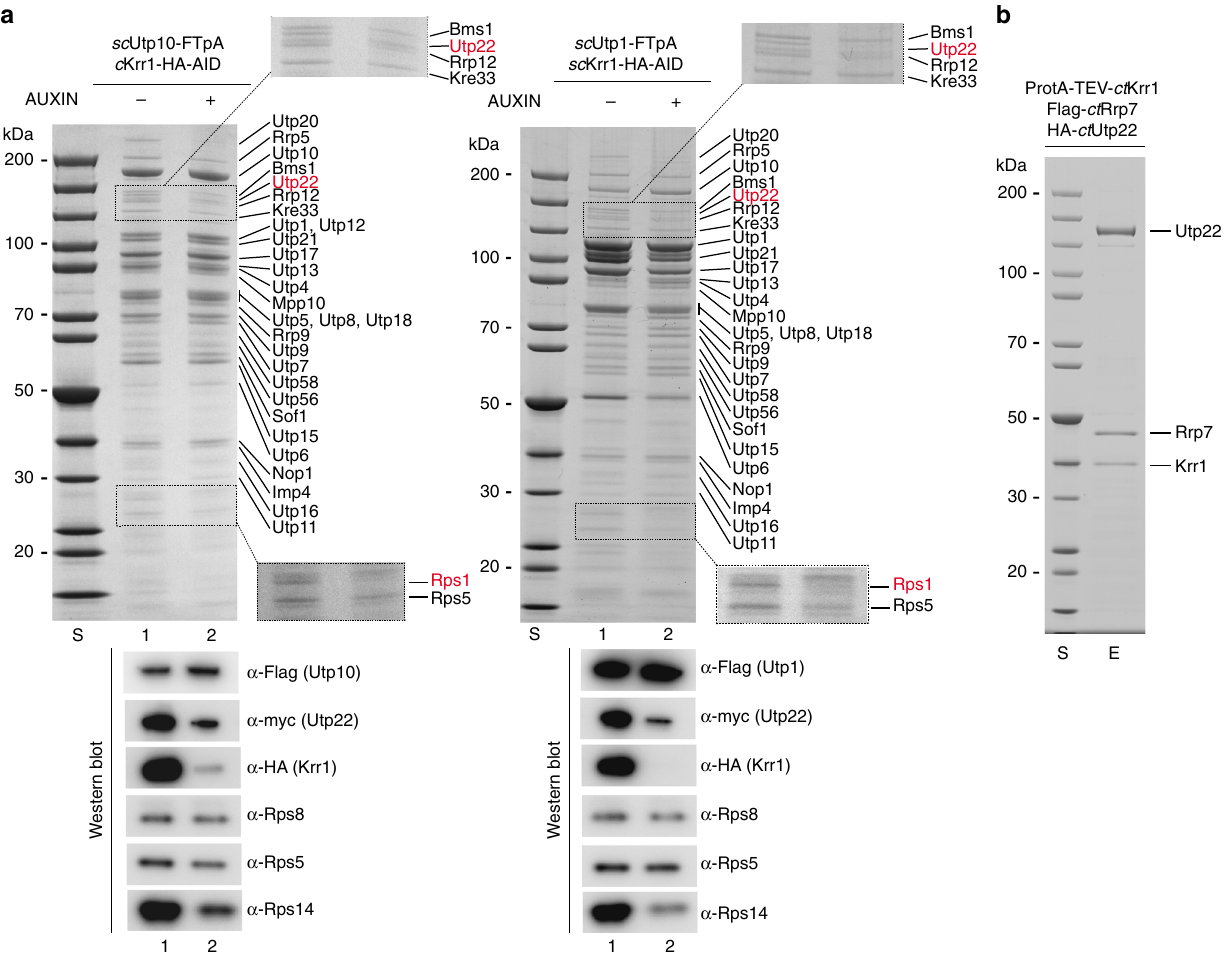
Fig. 5 Krr1 is required for recruitment of Rps1, Rps14 and UTP-C to the 90S pre-ribosome. a Depletion of Krr1 causes recruitment defects of the UTP-C complex, Rps14, and Rps1 to the 90S pre-ribosome. A yeast Krr1 degron strain ( sc Krr1-HA 3 -AID) expressing integrated sc Utp10-FTpA and sc Utp22-myc were grown in YPD medium, before degradation of Krr1 was induced by addition of indole-3-acetic acid (Auxin) to the medium and further growth for 90 min. Subsequently, sc Utp10-FTpA was af fi nity-puri fi ed and the eluates derived from the non-depleted and Krr1-depleted strains, respectively, were analyzed by SDS-PAGE (4 – 12%) and Coomassie staining (upper panel), or western blotting (lower panel) using the indicated antibodies. Dashed box is a zoom of the respective gel region to better display the Utp22/Rps1 depletion. Indicated proteins were identi fi ed via mass spectrometry. b Krr1 forms a complex with Utp22 and Rrp7 in vitro. The indicated ct Utp22-Rrp7-Krr1 complex was assembled by co-expression of the corresponding Chaetomium thermophilum factors in yeast followed by split-tag tandem af fi nity-puri fi cation. The fi nal eluate was analyzed by SDS-PAGE (4 – 12%) and Coomassie staining. Labeled bands were veri fi ed by mass spectrometry identi fi cation. The experiments were performed at least twice with consistent results. Uncropped images are shown in Supplementary Fig. 9. S molecular weight protein standard, E